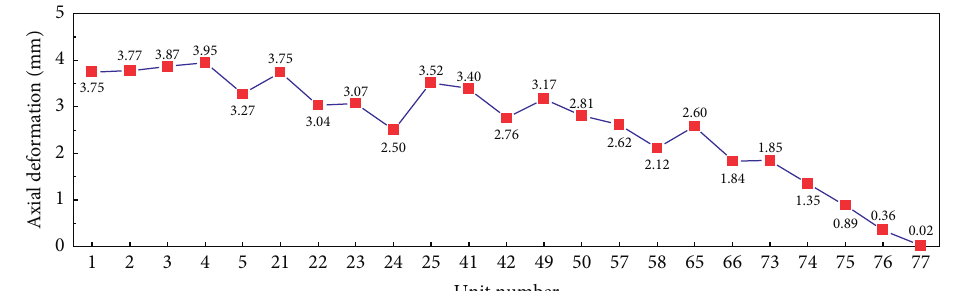
Figure 10: Variations of the axial deformation with the unit number for the first